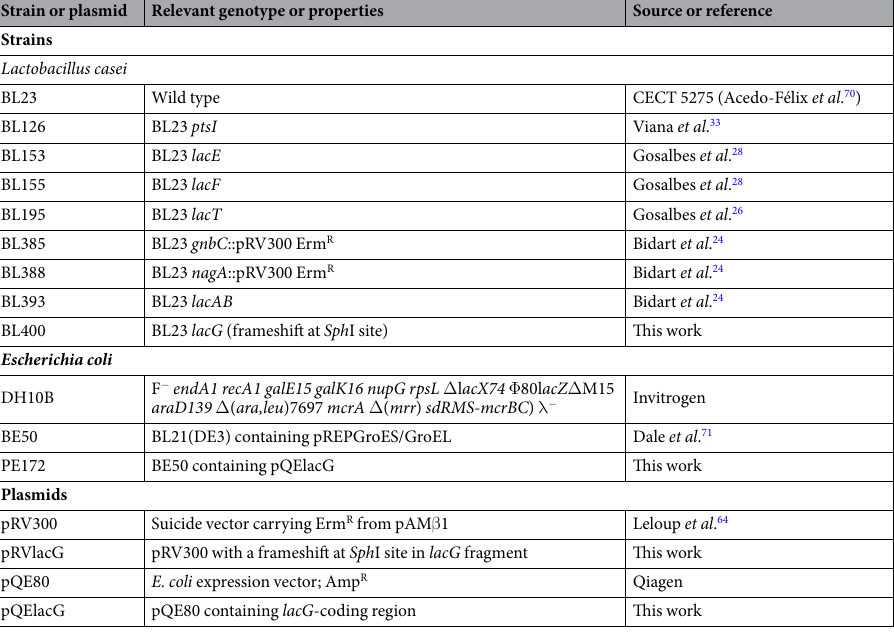
Table 2. Strains and plasmids used in this study a . a CECT, Colección Española de Cultivos Tipo; Erm R , erythromycin resistance; Amp R , ampicillin